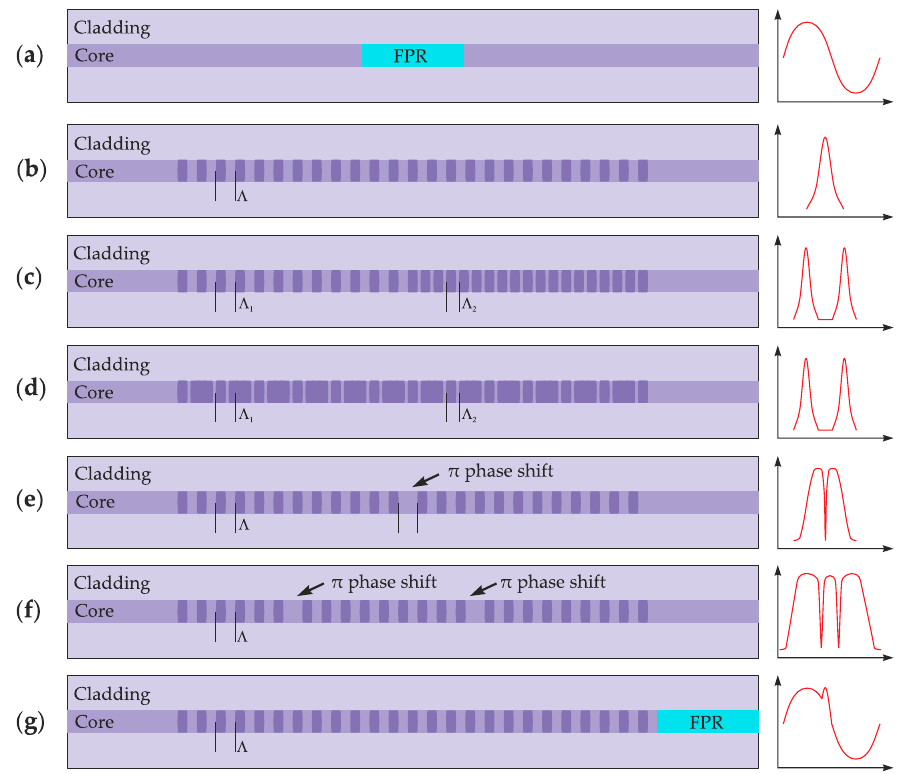
Figure 1. Several types of layered structures formed in the optical fiber core: ( a ) Fabry–Perot reso- nator (FPR); ( b ) fiber Bragg grating (FBG); ( c ) two sequential FBGs; ( d ) two FBGs recorded one over the other; ( e ) FBG with π phase shift; ( f ) FBG with two π phase shifts; ( g ) FBG and FPR combina- tion.